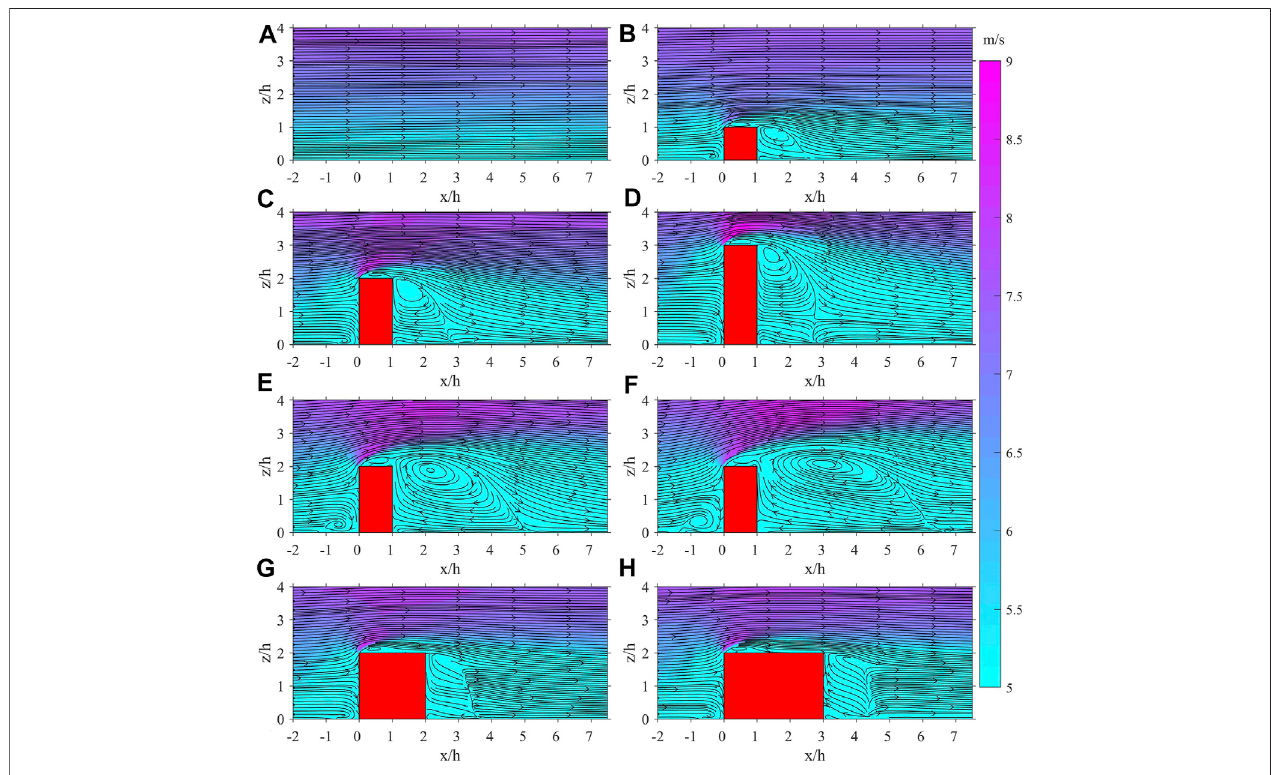
FIGURE8| Meanvelocitystreamlinessuperimposedonthecontourplotsofmeanvelocitymagnitudeatslice y (cid:3) 0 (A) withnostructure;andwithstructurewith (B) L (cid:3) W (cid:3) H (cid:3) 3 m; (C) L (cid:3) W (cid:3) 3 m, H (cid:3) 6 m; (D) L (cid:3) W (cid:3) 3 m, H (cid:3) 9 m; (E) L (cid:3) 3 m, W (cid:3) H (cid:3) 6 m; (F) L (cid:3) 3 m, W (cid:3) 9 m, H (cid:3) 6 m; (G) L (cid:3) H (cid:3) 6 m, W (cid:3) 3 m; (H) L (cid:3) 9 m, W (cid:3) 3 m, H (cid:3) 6